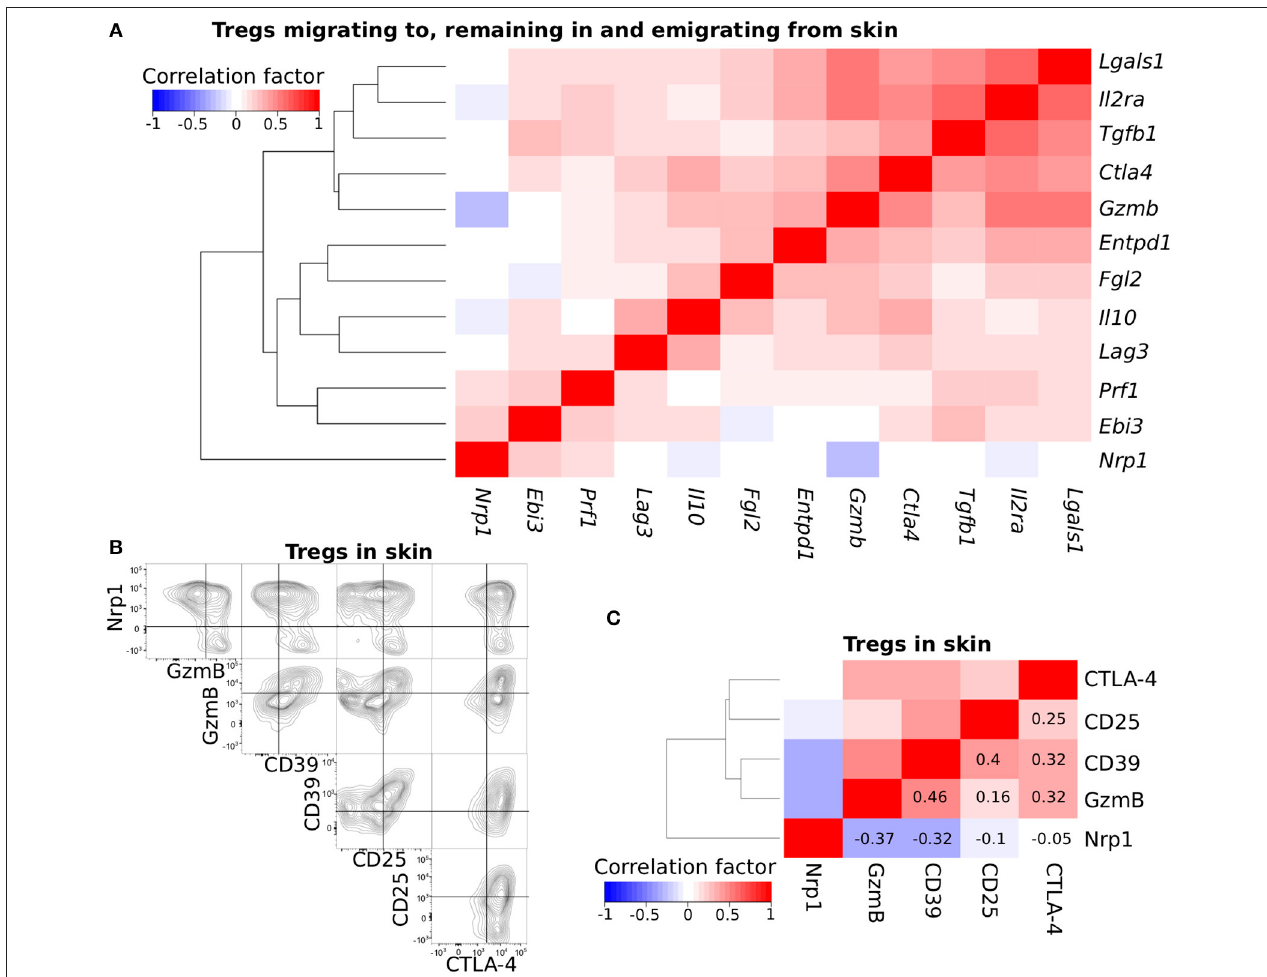
FIGURE 2 | Cross-correlation analysis of functional molecule expression profiles. (A) Cross-correlation analysis of the expression profiles for genes related to Treg function. scqPCR data was formed by concatenating the data from the three Treg populations. Colors indicate positive (red) or negative (blue) correlations. (B) Nrp1, GzmB, CD39, CD25, and CTLA-4 protein expression levels of Tregs in inflamed skin. Flow cytometry (FCM) data are representative of three independent experiments. Lines in plots indicate boundaries between positive and negative cells. (C) Cross-correlation analysis of the expression profiles for five proteins using pooled FCM data ( n = 3). Clustering was performed by the Manhattan distance and group average